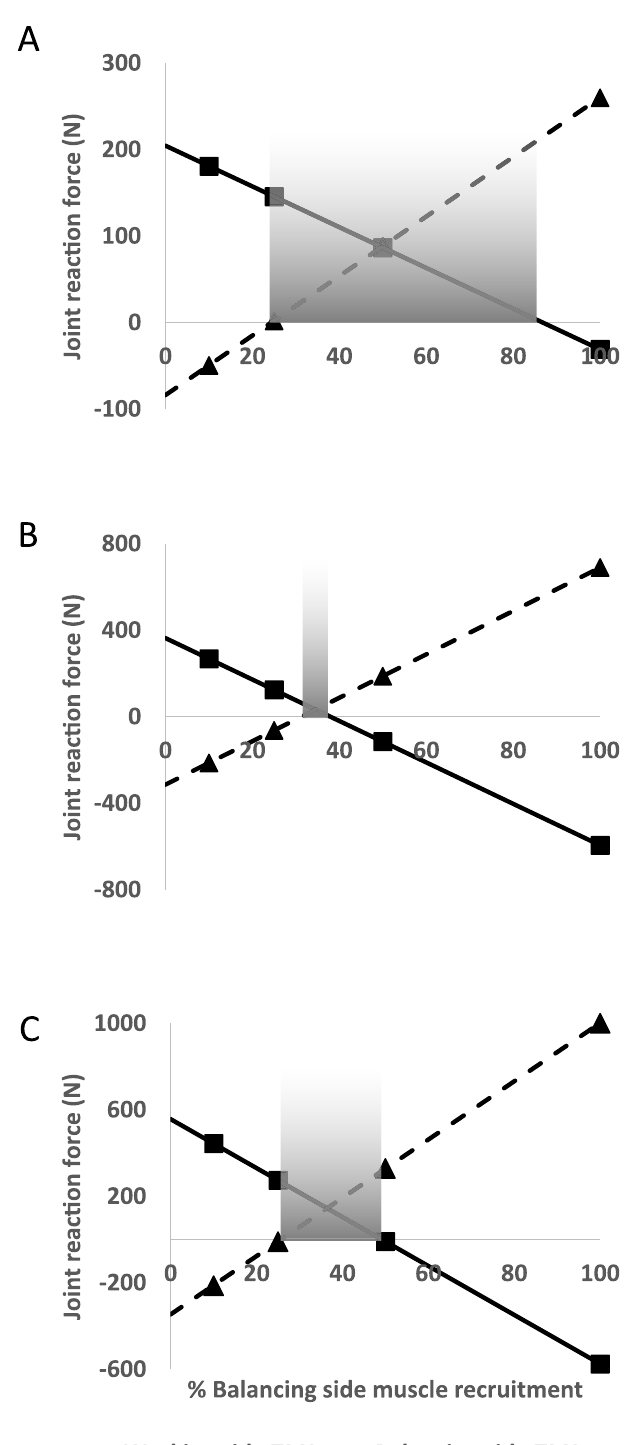
Fig 2. Plots of working and balancing TMJ reaction forces during M4 biting across the entire range of balancing- side muscle recruitment, interpolated from the four measurements (triangles and squares). Negative values indicate tensile forces. Shaded regions indicate potential ranges of muscle recruitment that result in a balanced triangle of support. (A) A broad range of balancing-side muscle recruitment is observed for M4 biting in the koala model (B) the Simosthenurus occidentalis model with tree-kangaroo muscle proportions has almost no range of balance at the